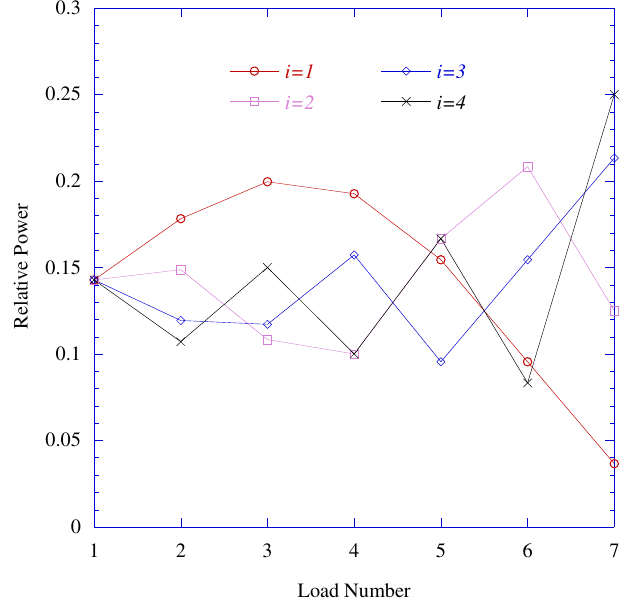
FIG. 4. (Color) Power distribution over the loads for a system satisfying Eq. (10). The number of directional couplers and loads is seven and the number of accelerator structures is